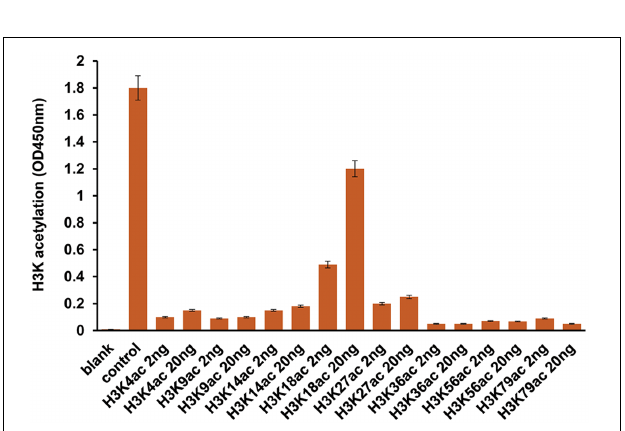
FIGURE 5 | 2-AA modulates H3K18 acetylation. Screening for Histone H3 acetylation following 2-AA stimulation. Nuclear extraction was prepared from THP-1 cells 1 h post-stimulation with 2-AA. The interaction of the enzyme in the sample solution with the acetylated H3K peptides was measured by using Histone H3 Peptide Array ELISA kit (number of replicates = 2; means ±